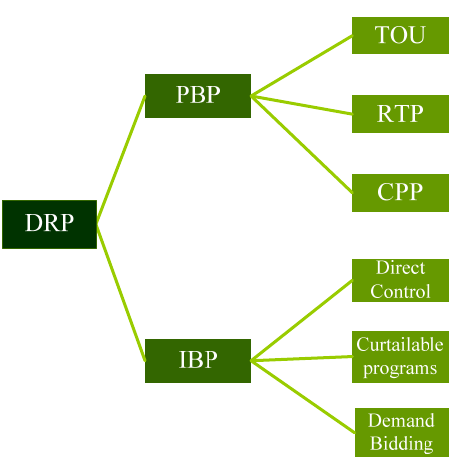
Figure 1. Catalogue of